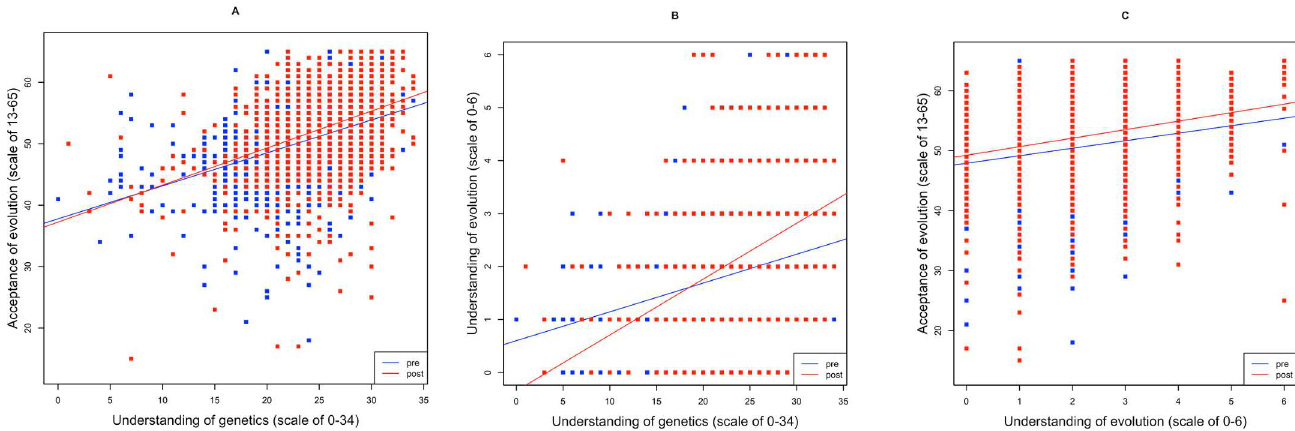
Fig 6. A . Relationship betweenacceptanceof evolutionand understanding of genetics, before and after learningabout evolutionand genetics. B . Relationship betweenunderstanding of evolutionand understanding of genetics, before and after learningabout evolutionand genetics. C . Relationship betweenacceptanceof evolutionand understanding of evolution, before and after learningabout evolutionand genetics. Here, we employ the subset of data for pupils who completedall pre- and all postquestionanaires.Regression lines are for indicativepurposes alone.Raw data can be found in S1 and S2